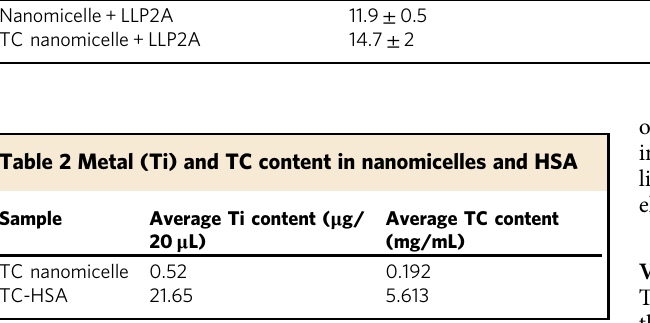
Table 1 Size distribution of the nanomicelles Sample